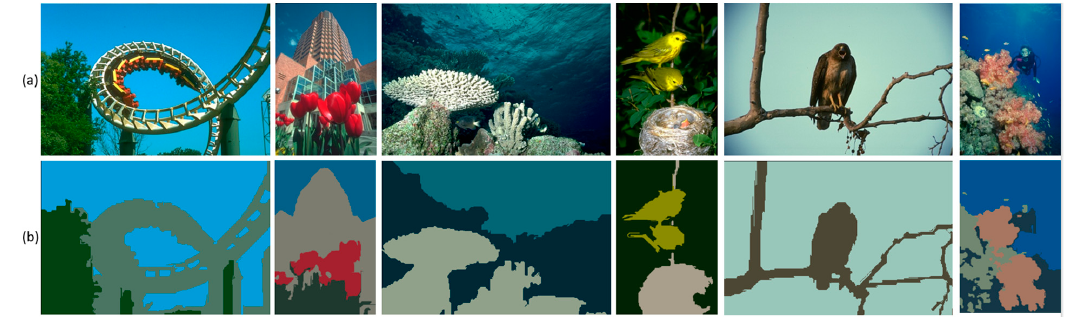
Figure 3. Segmentation results. From top to bottom: ( a ) Original images, ( b ) segmentation results of proposed algorithm.